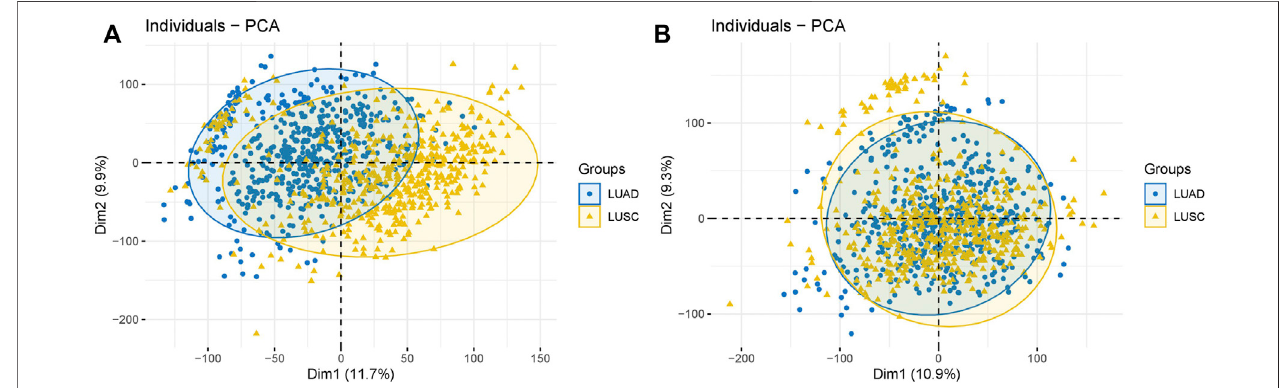
FIGURE 1 | Batch effect removal. (A) Before batch effects were removed. (B) After batch effects were removed.